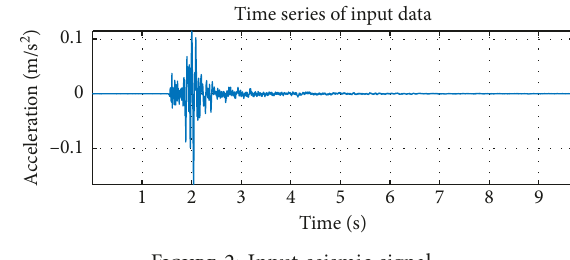
Figure 2: Input seismic signal.